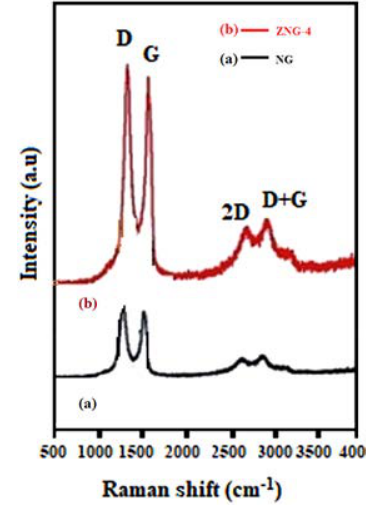
range of defects: bond angle disorder, bond length disor-